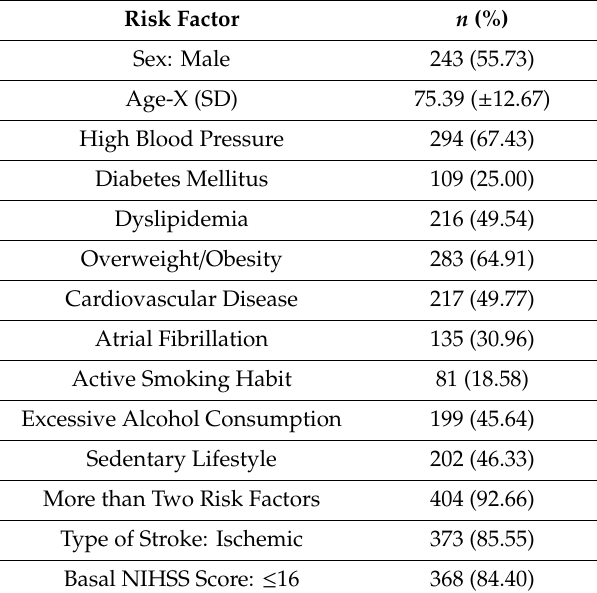
Table 1. Characteristics of patients.